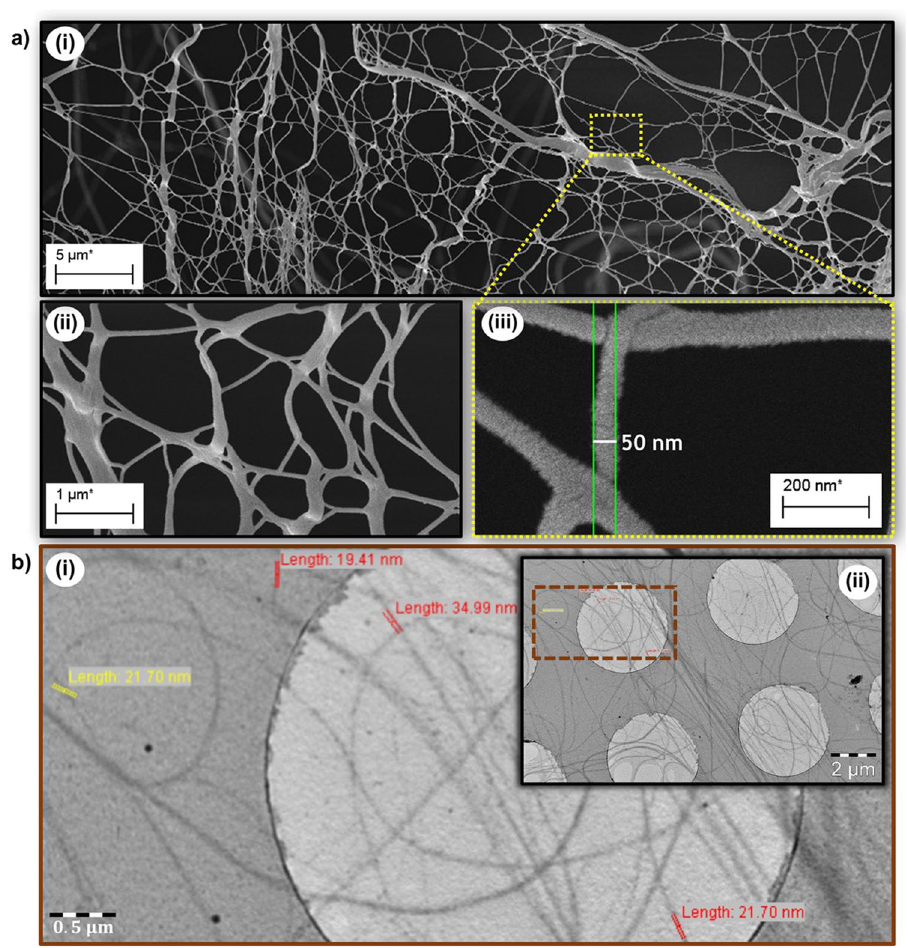
Figure 5. ( a ) SEM micrograph of gold-coated chia seed fibers: at (i) 4,400X magnification, (ii) 30,000X magnification, and (iii) 150,000X magnification showing fiber diameter of ~50 nm. ( b ) TEM micrograph of drop-casted aqueous solution of chia seed fibers: (i) zoomed image showing fiber diameters as low as ~20 nm, (ii) inset showing full